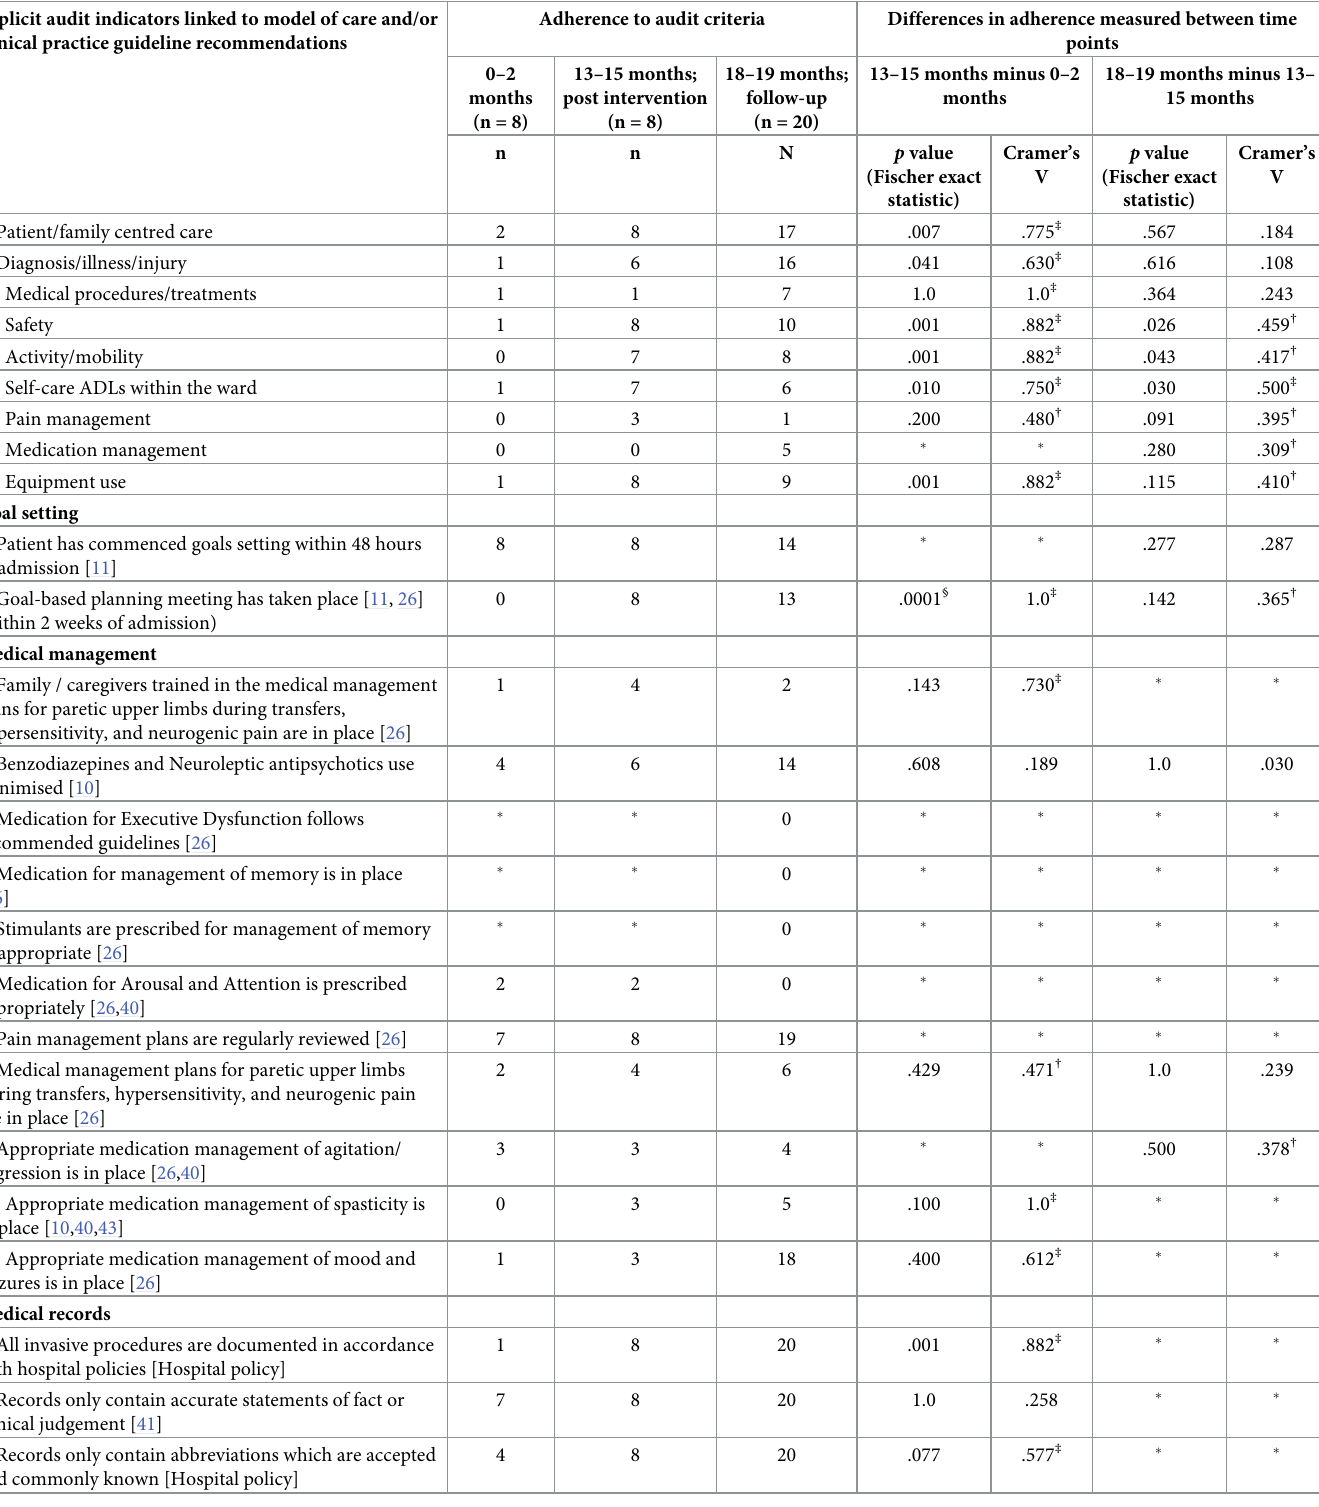
Explicit audit indicators linked to model of care and/or clinical practice guideline